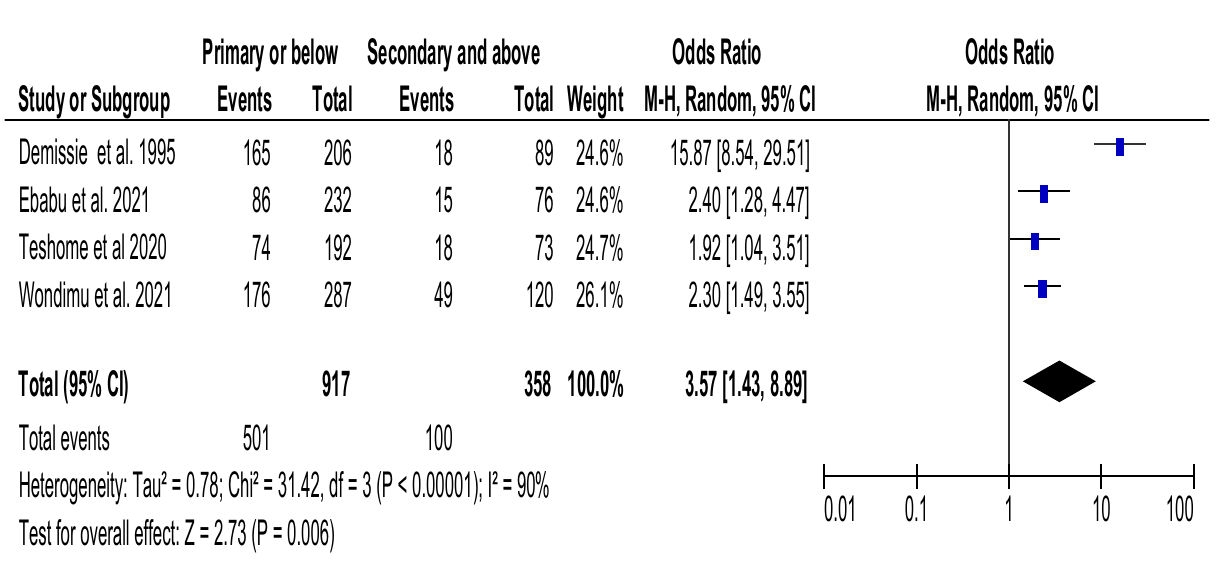
Figure 6. Forest plot using an unadjusted odds ratio for the association between age and food taboo practices among pregnant women in Ethiopia, 2022.